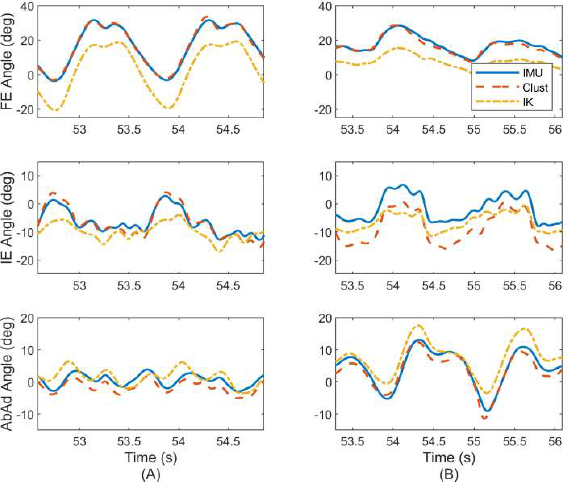
Figure 10. Representative hip joint angle estimates over two stride cycles for two different gaits. Hip joint angle estimates for normal treadmill walking ( A ) and lateral left walking ( B ). Estimates are made utilizing ErKF (IMU), cluster (Clust), and inverse kinematics (IK) methods.